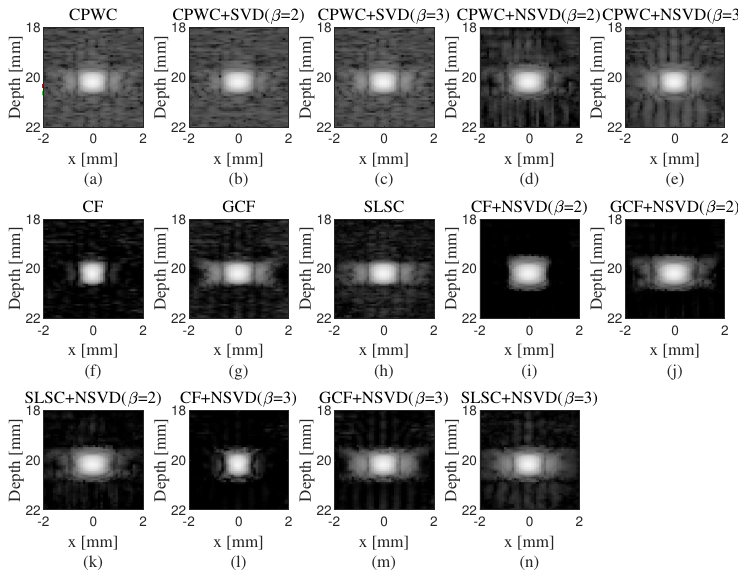
Figure 2. Simulated point target images formed by different methods and displayed with a dynamic range of 80 dB. ( a – n ) Zoomed images of the point target at a depth of 20 mm in Figure 1a–n, respectively.